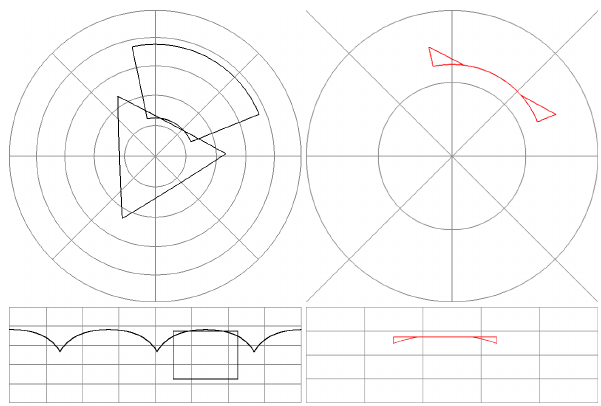
Figure 2. Clipping of ICON triangle and ECHAM